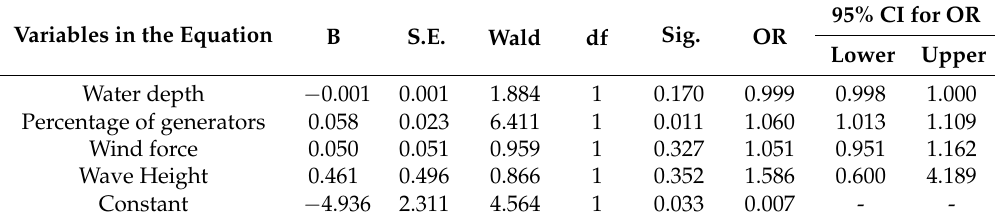
Table 3. Variables in the equation in Step 2. Variables in the